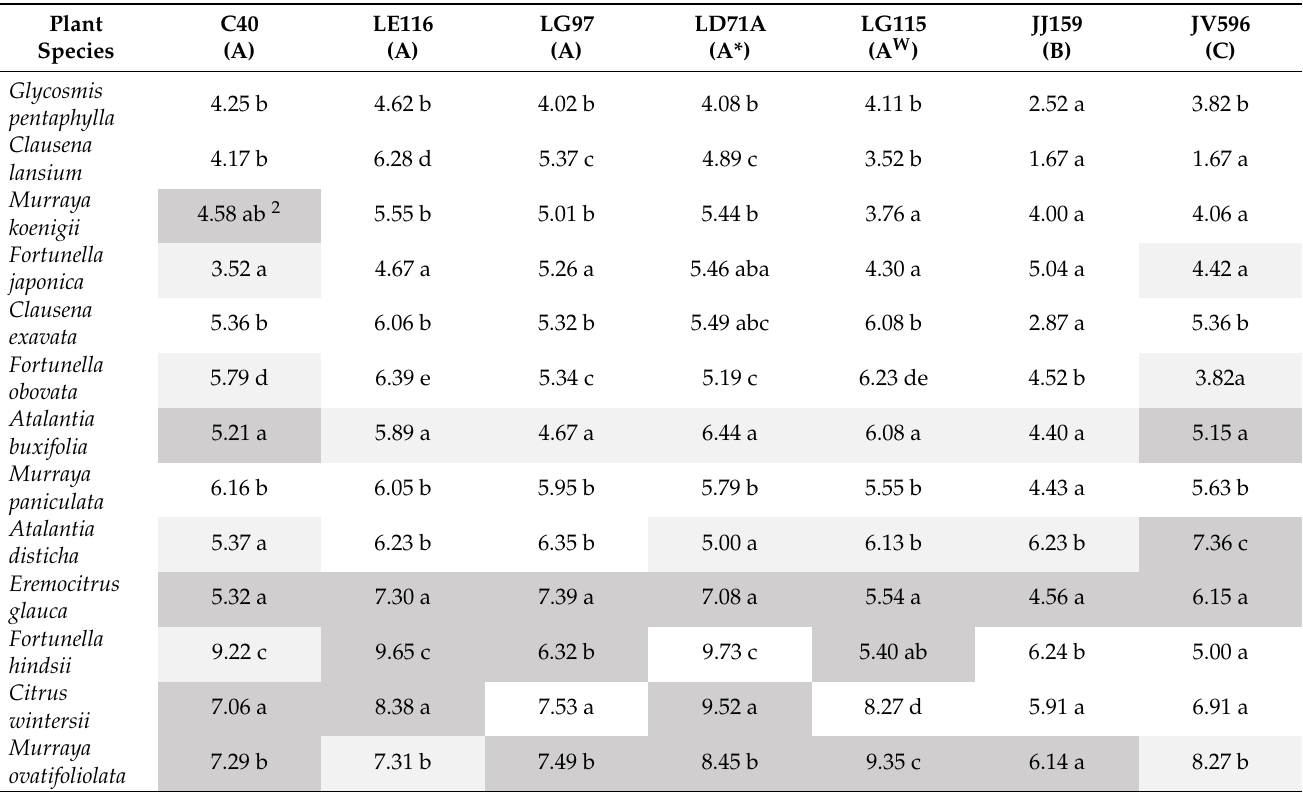
Table 4. Xanthomonas citri pv. citri and X. citri pv. aurantifolii bacterial population size (Log cfu mL − 1 ) estimated at the inoculation point of detached leaves of representative ornamental rutaceous plants 1